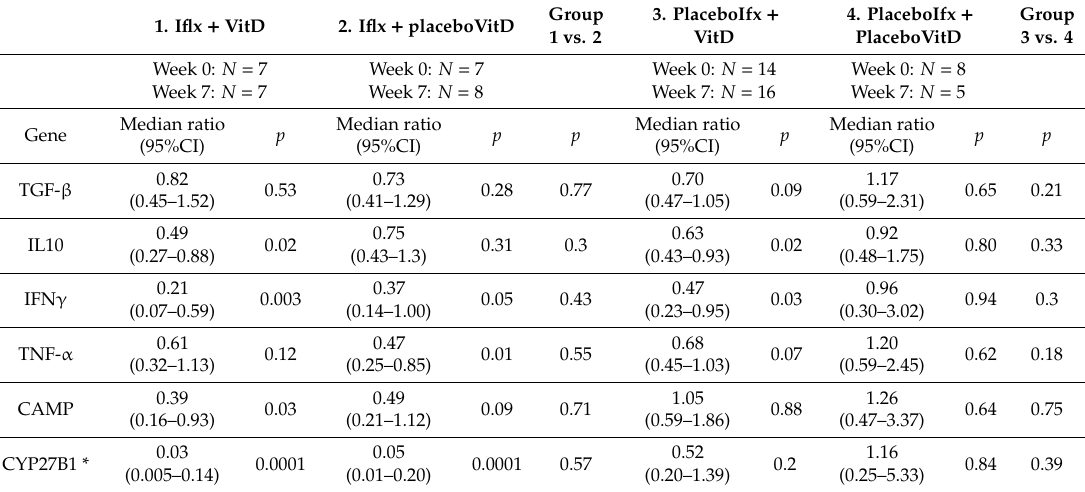
Table 3. Changes in mucosal mRNA expression of from week 0 to